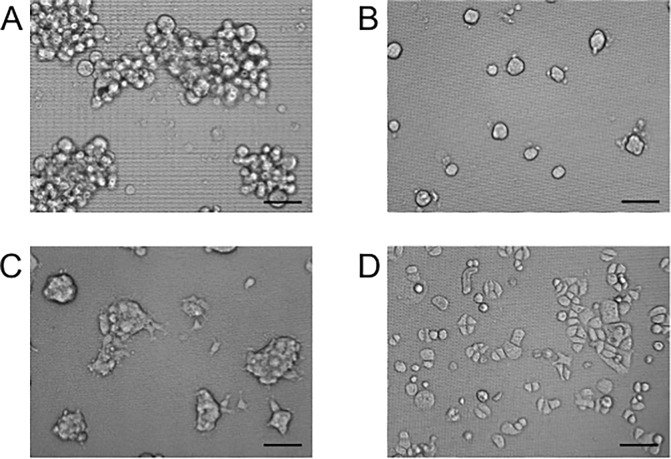
Representative morphologies of the various types of cell aggregates formed on NanoCulture Plates (NCP).(A) Grape-like aggregation (GLA) of PC-3 cells formed in F12K medium with 10% FBS. (B) Spheroids of CAL 27 cells formed in DMEM with 10% FBS. (C) Cell aggregation of FaDu cells formed in DMEM with 10% FBS. (D) Epithelial monolayer sheet of RT7 cells formed in KGM2 medium. Scale bar, 100 μm. The morphological classification of 67 cell lines on NCP is shown in Table 1.